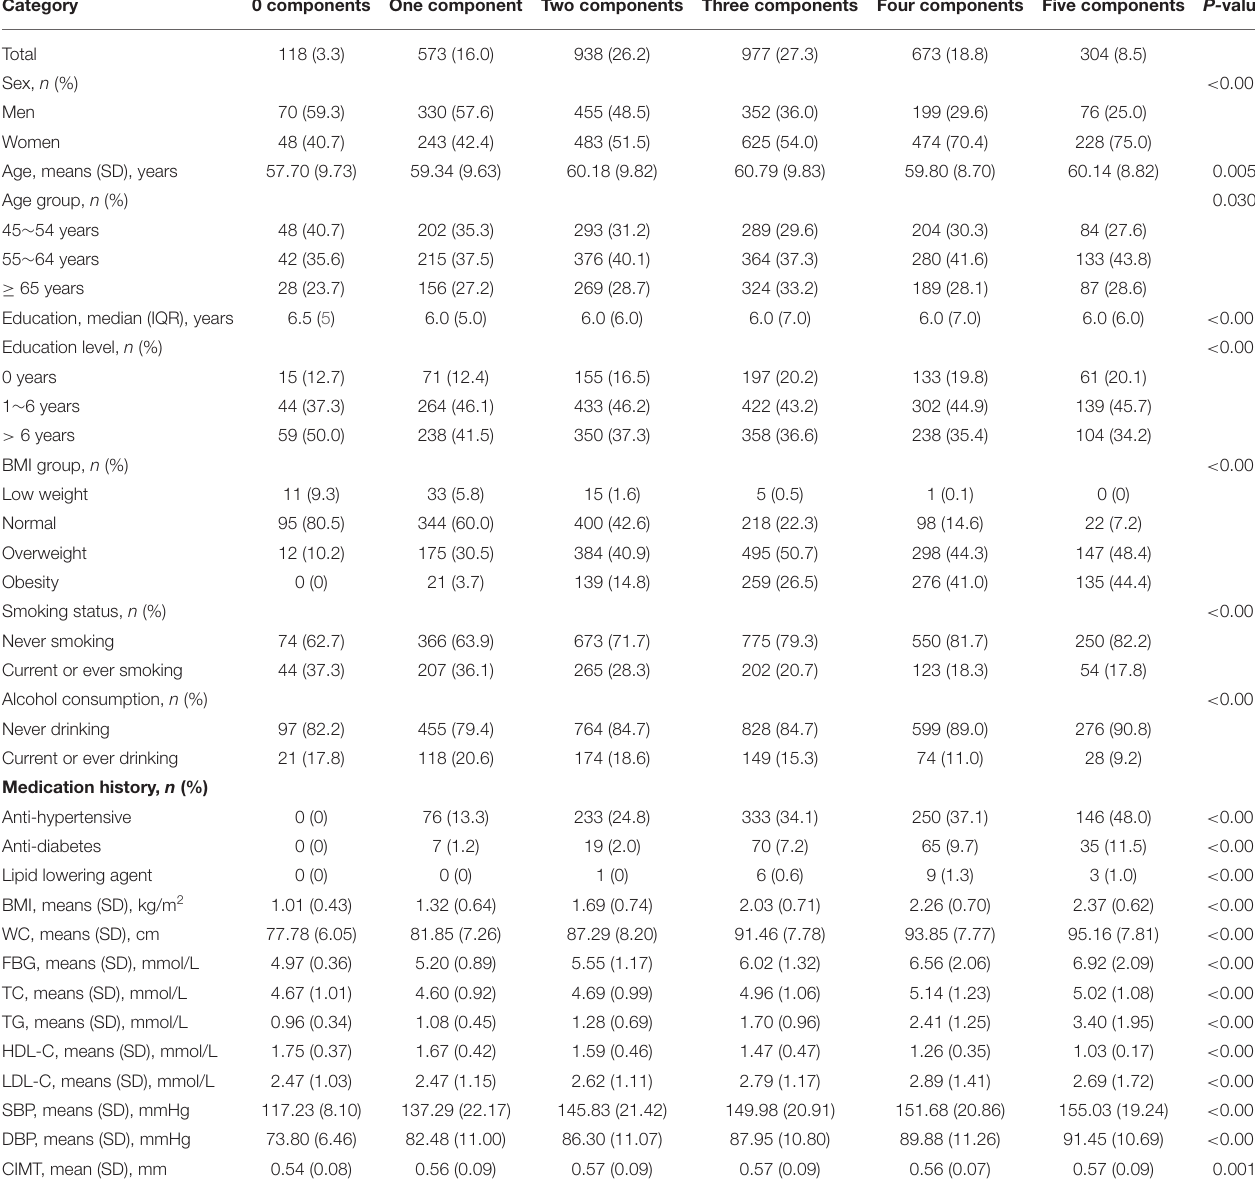
TABLE 2 | Characteristics of study participants stratified by MetS components.